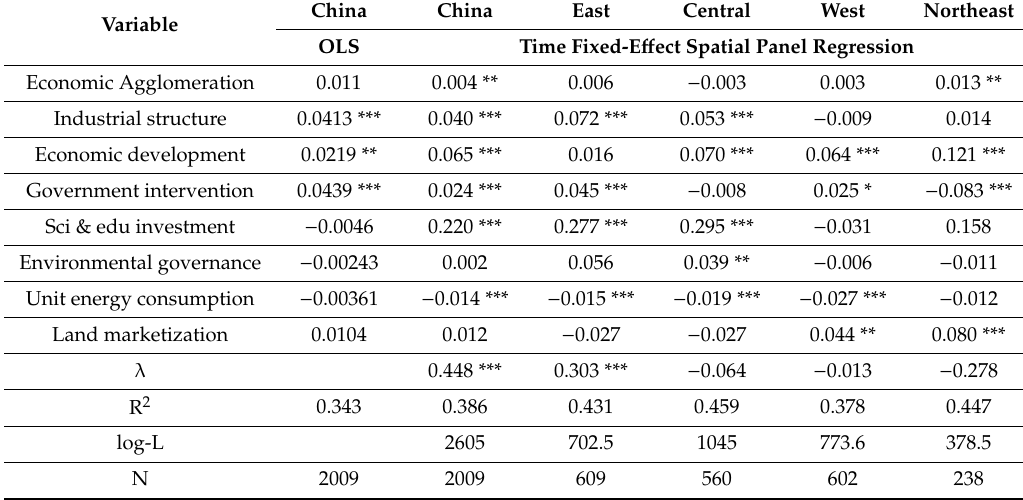
Table 6. Regression results of influencing factors of